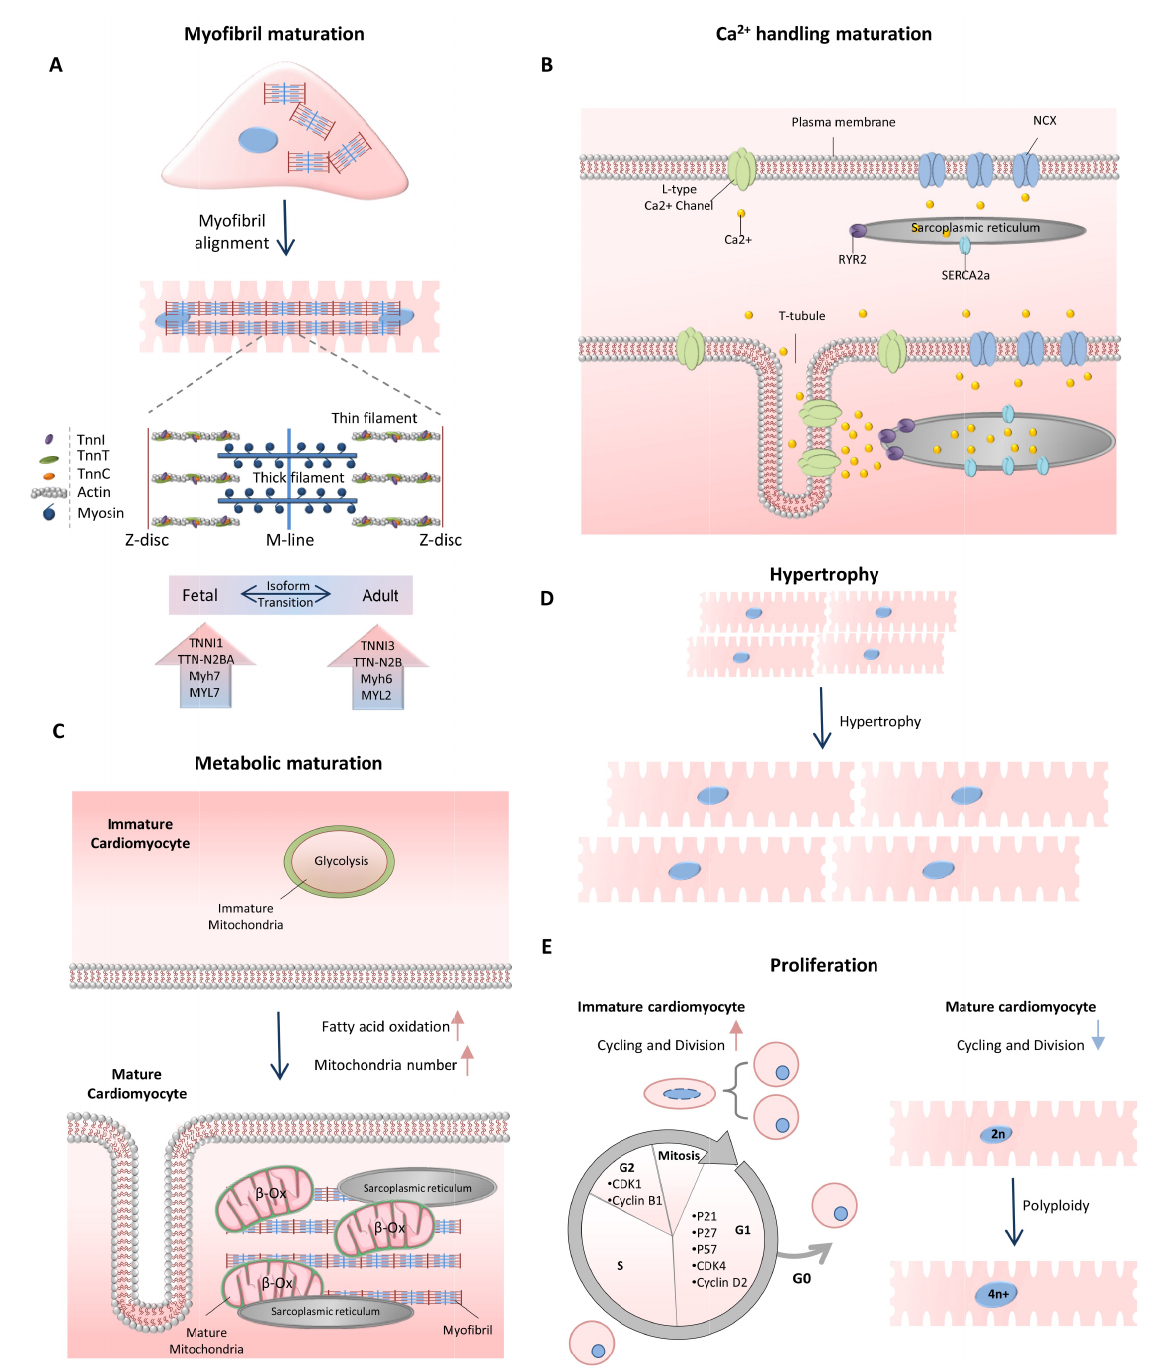
Figure 1. Cardiomyocyte maturation characteristics. ( A ) Cardiomyocytes undergo myofibril maturation, which is followed by increasing the sarcomere length, assembly and expansion; improvement of sarcomere alignment and M-line formation. ( B ) Calcium handling maturation is mediated by the development of T-tubules, expression of calcium handling proteins and increased volume of calcium stores of the sarcoplasmic reticulum. ( C ) Metabolic maturation causes the switch of glycolysis to fatty acid β -oxidation and increases in mitochondria number. The cristae structures in mitochondria are densely organized, and the mitochondria are localized close to the SR and myofibrillar structures to support efficient ATP transition. ( D,E ) Proliferation-to-hypertrophy transition occurs at the time of maturation. The postnatal heart size is increased through maturational hypertrophy followed by polyploidization (top) cardiomyocyte proliferation rate declines through downregulation of cell-cycle-associated genes